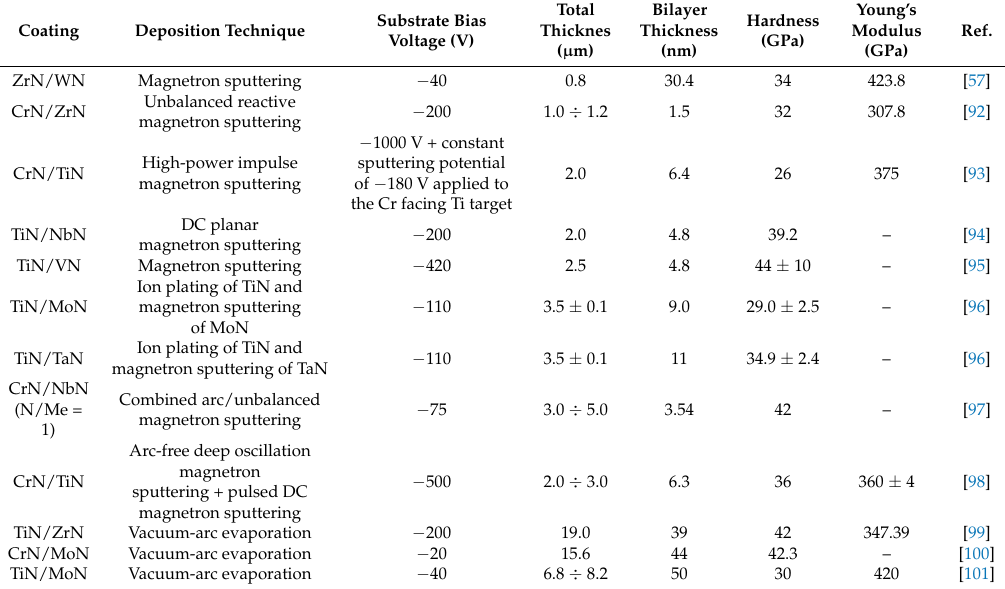
Table 2. Deposition parameters Mechanical properties of different bilayer nitride coatings.